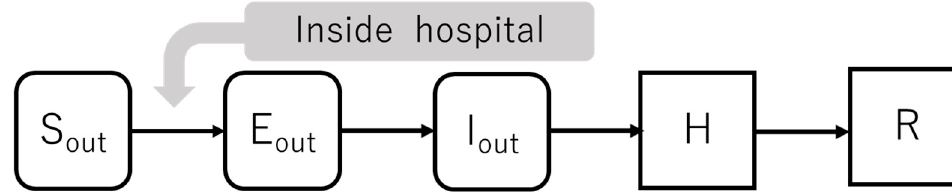
Figure 4. Infection flow diagram outside hospital.